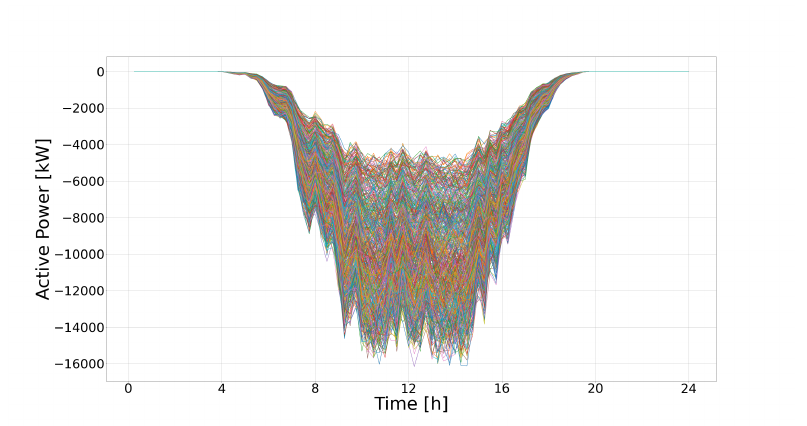
Figure 17. PV generation time series scaled with a random factor between 0.5 and 1.5.